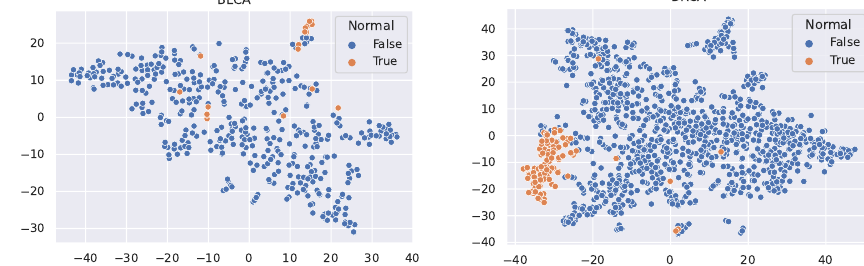
Figure 3. t-SNE visualisation of BLCA and BRCA.